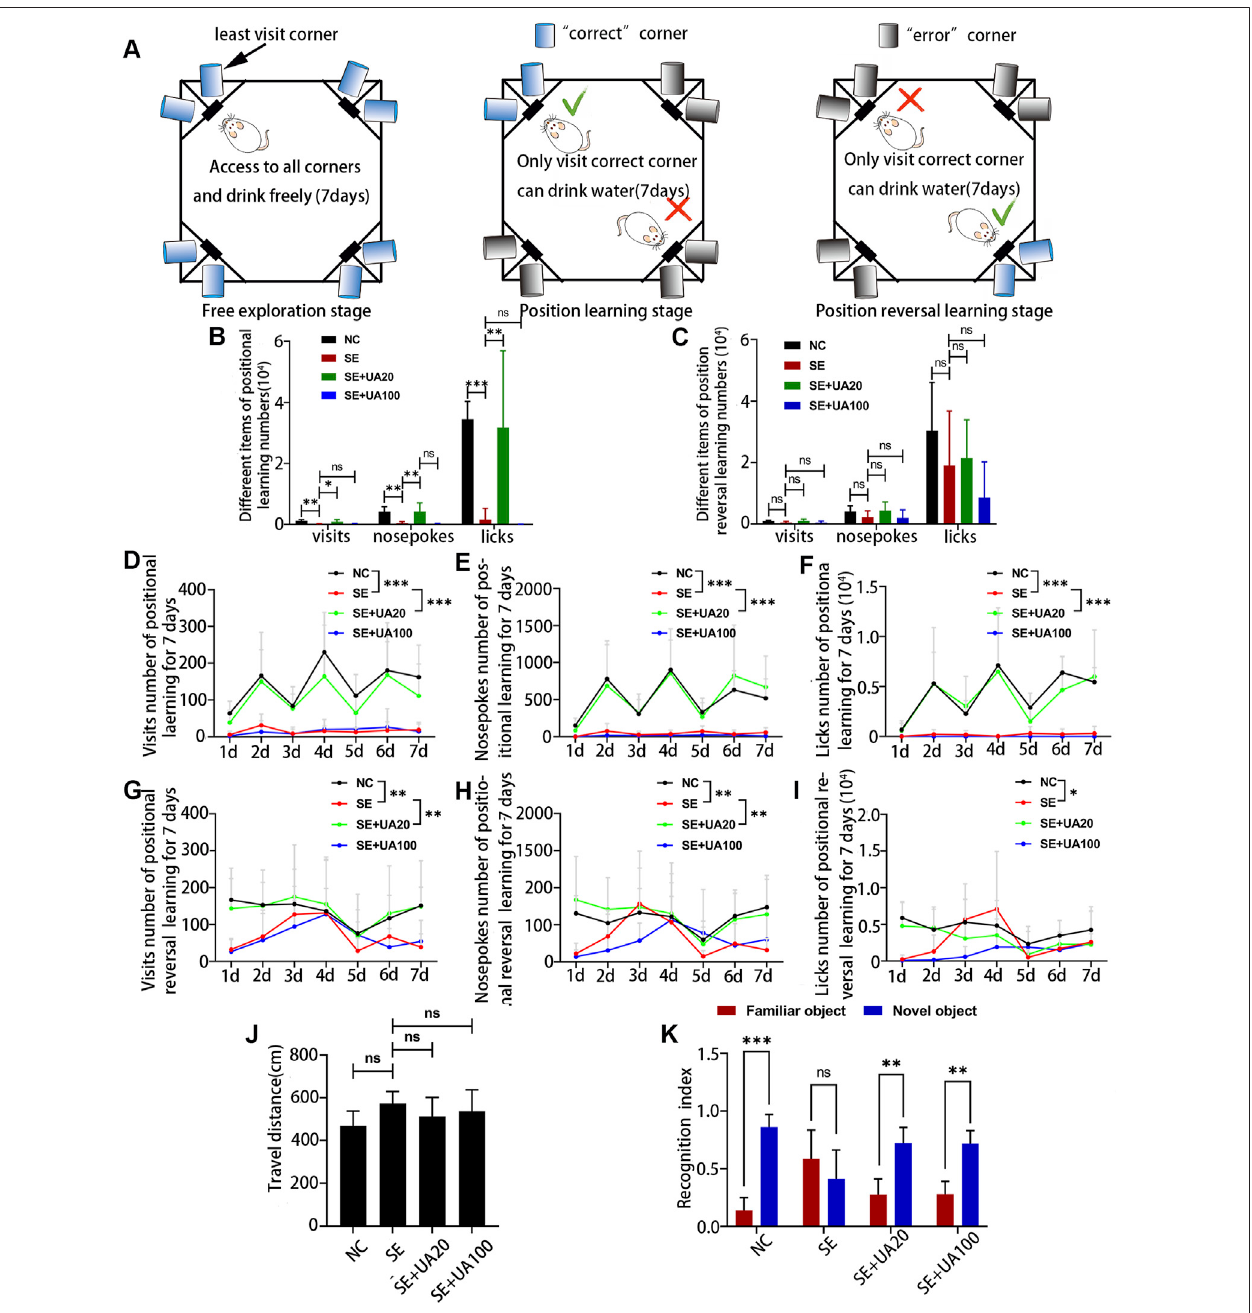
FIGURE 3 | UA improved cognitive dysfunction induced by epilepsy. (A) Architectural diagram of IntelliCage and experimental program settings. Cage was not drawntoscale. (B) The number ofdifferent items ofpositional learningstage and (C) positional reversal learning stage. Number ofvisits (D) , nosepokes (E), and licks (F) in positional learning from d 1 to d 7. Number of visits (G) , nosepokes (H), and licks (I) in positional reversal learning from d 1 to d 7. (J) Open- fi eld test of rats with developed SE induced by pilocarpine at 5 weeks. (K) Novel object recognition test of rats with developed SE induced by pilocarpine at 5 weeks. ( n = 6, all values were expressed as means ±SD, ppp p < 0.001, pp p < 0.01, p p < 0.05 vs . SE, one-way ANOVA, two-way ANOVA, or paired t